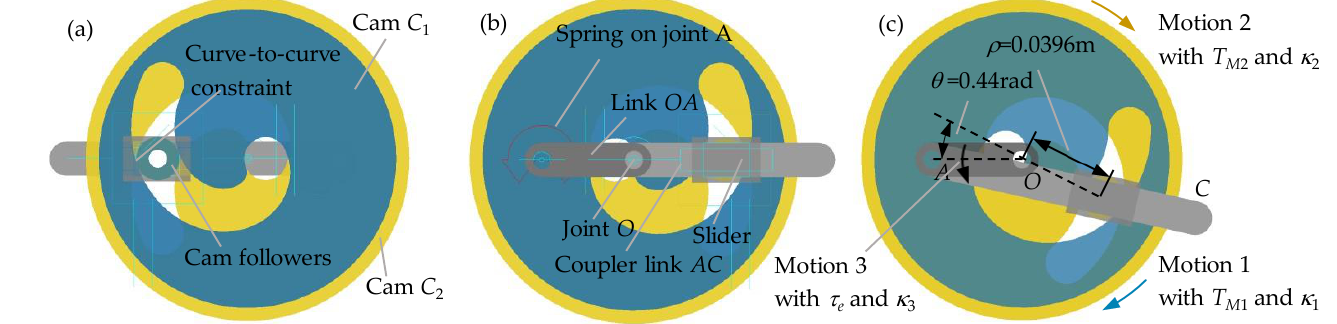
Figure 10. The virtual prototype in ADAMS ( a ) Bottom view; ( b ) Front view; ( c ) Deformed configura-